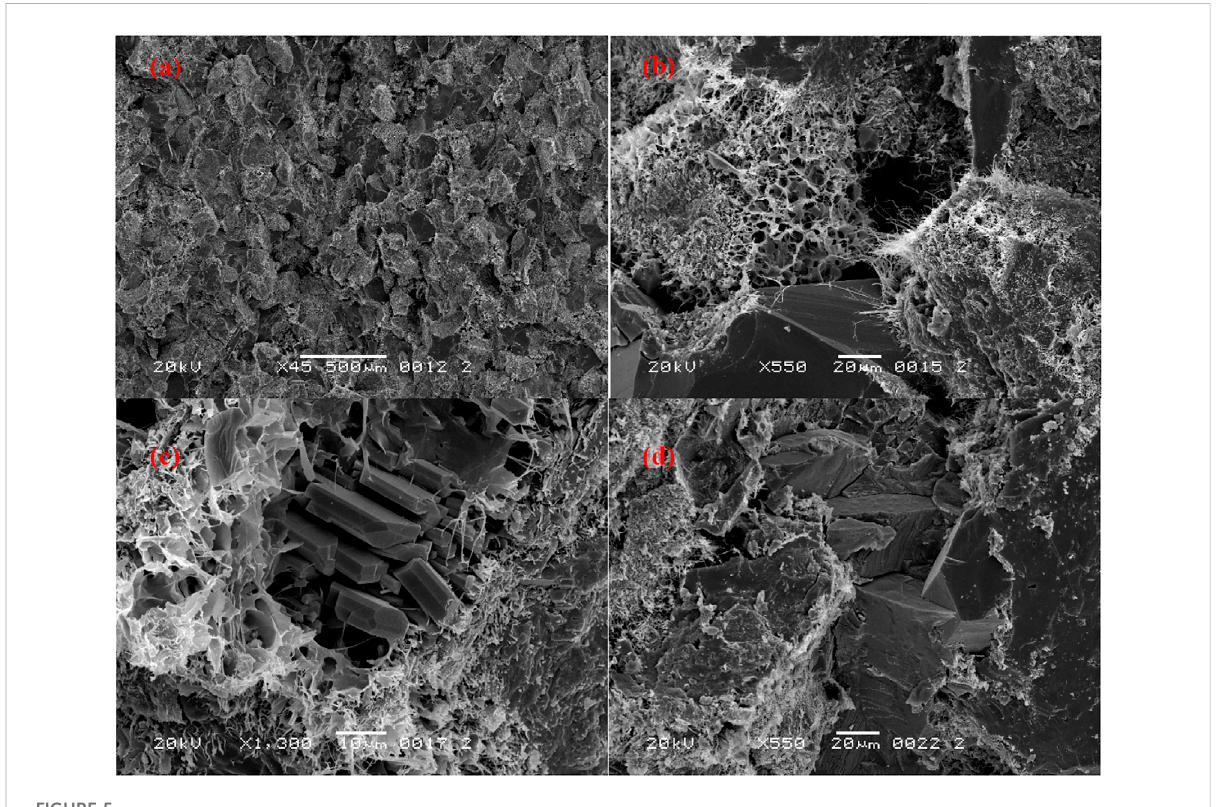
FIGURE 5 SEM image of No. 3 core of Zhoufu 59 – 51